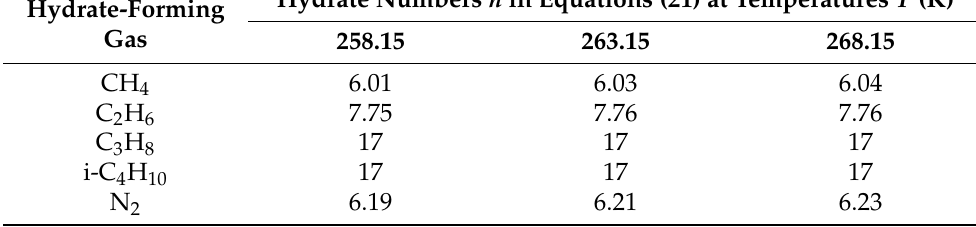
Table 2. Hydrate numbers for some gases at T < 273 K on three-phase gas–ice–hydrate equilibrium line of.